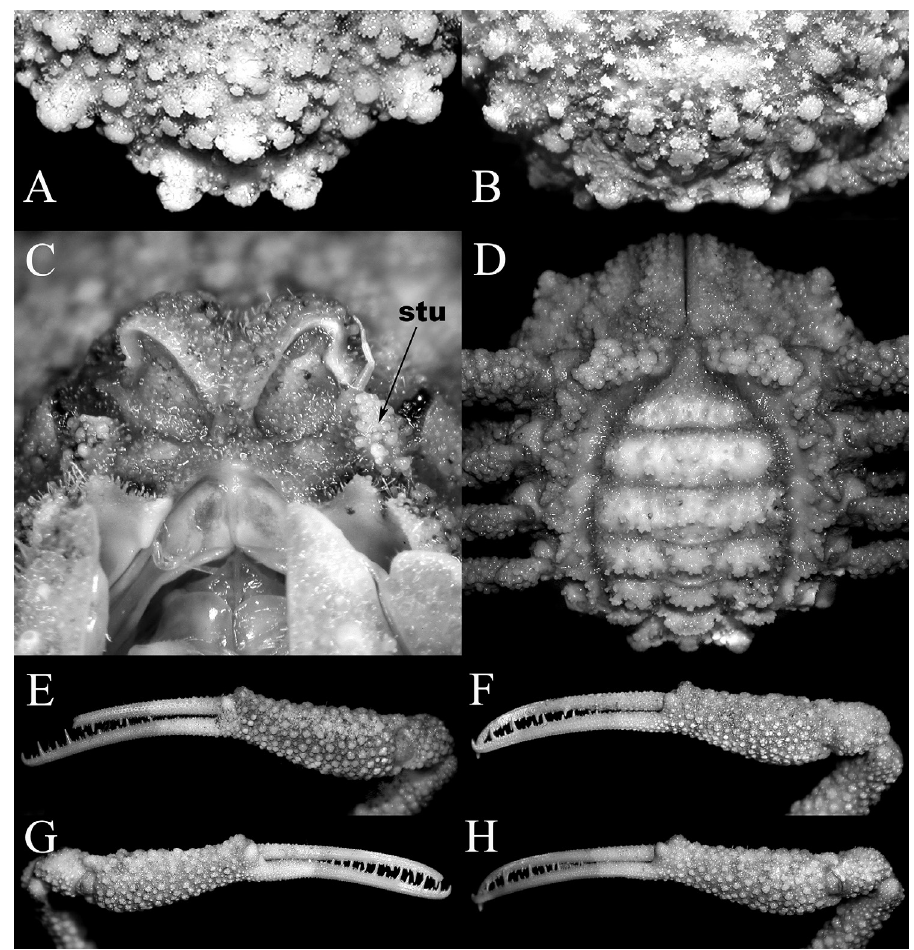
Figure 9. Pariphiculus stellatus sp. n. A, C, E holotype male (27.7 × 24.5 mm) (ASIZ 75485), Taiwan B female (32.3 × 27.6 mm) (ZRC 2017.185), Philippines F male (24.3 × 21.6 mm) (ZRC 2007.590), Philippines D, G, H female (35.1 × 29.6 mm) (ZRC 2007.590), Philippines. A, B intestinal region and posterior margin of carapace C antennae, antennules and orbit D female thoracic sternum and pleon E, F, H outer view of left chela G outer view of right chela. Abbreviation: stu = suborbital